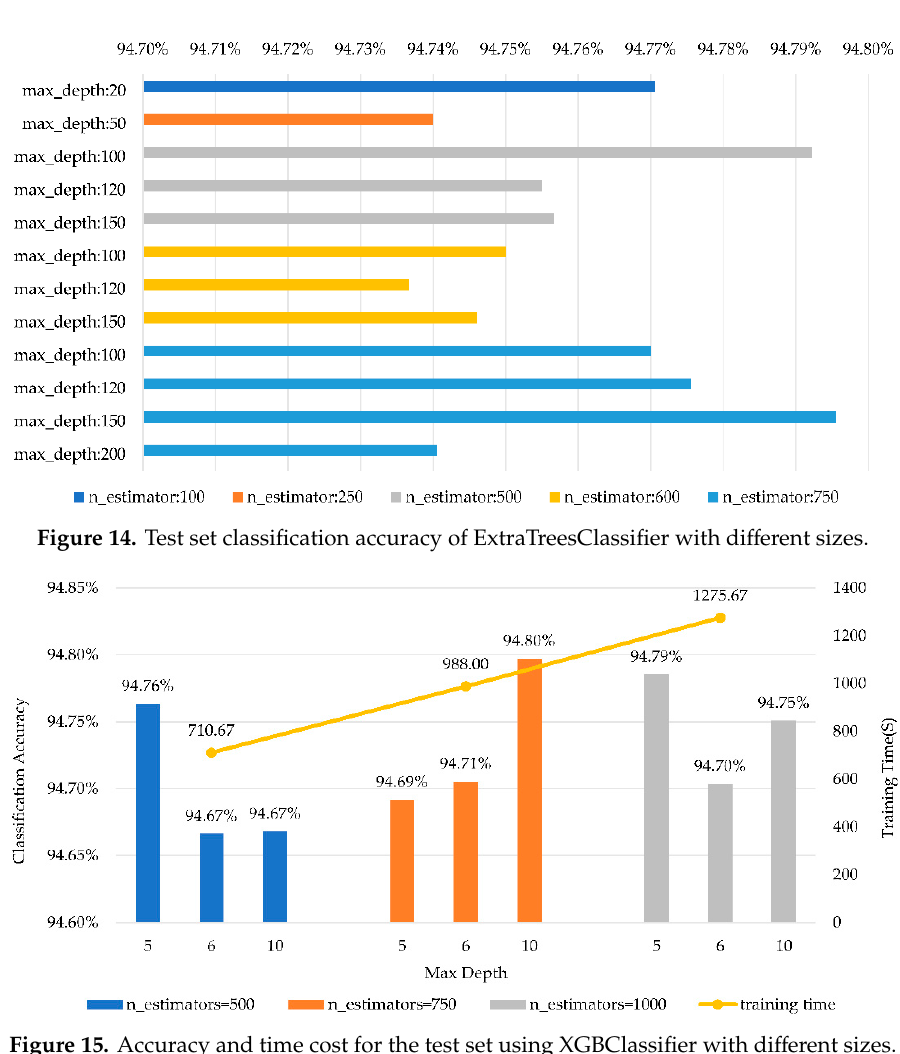
Figure 15. Accuracy and time cost for the test set using XGBClassifier with different sizes.